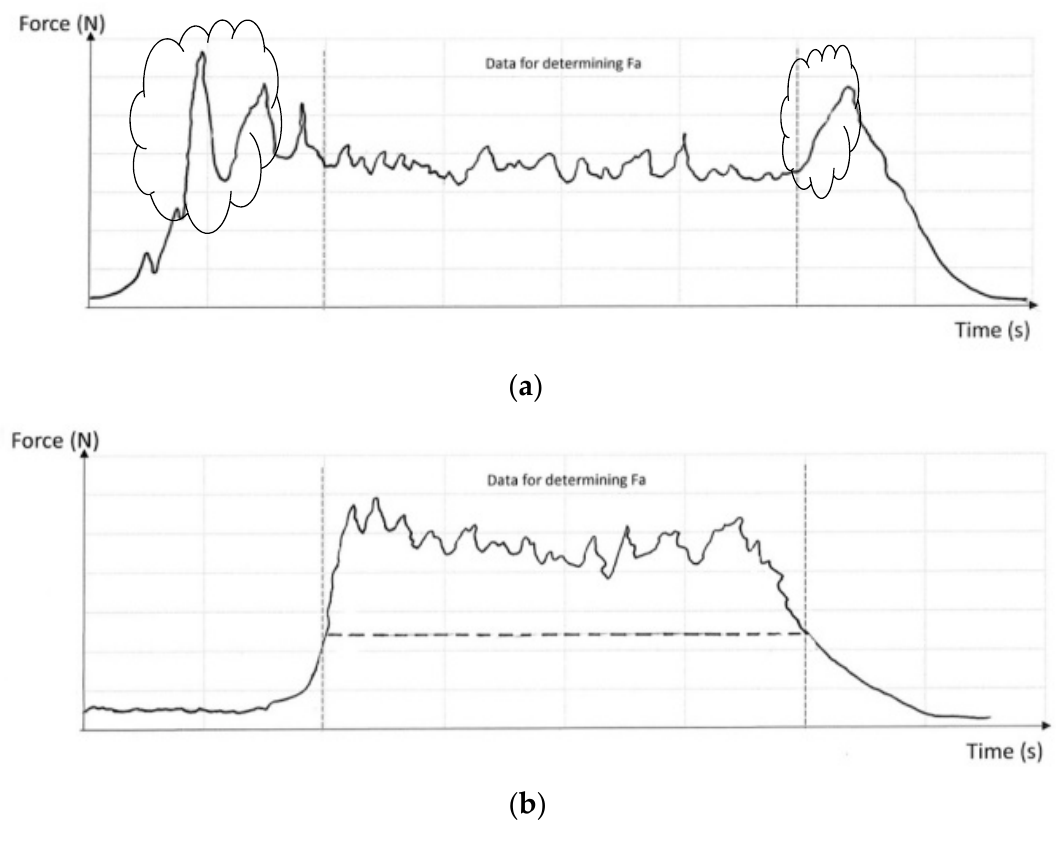
Figure 6. Dynamic behavior testing procedure. 1 Energy Absorber Lanyard 2 Connectors 3 Rigid mass of 100 kg 4 Load Cell 5 Anchor point 6 Steel structure